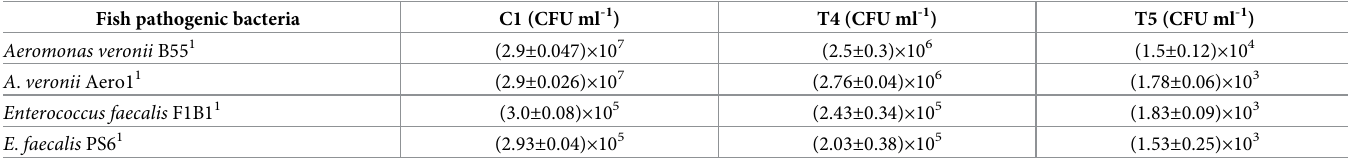
Table 4. Effects of graded levels of dietary chitosan on the growth of fish pathogenic bacterial strains collected from the laboratory. Values are the mean ± SEM (N = 3). Fish pathogenic